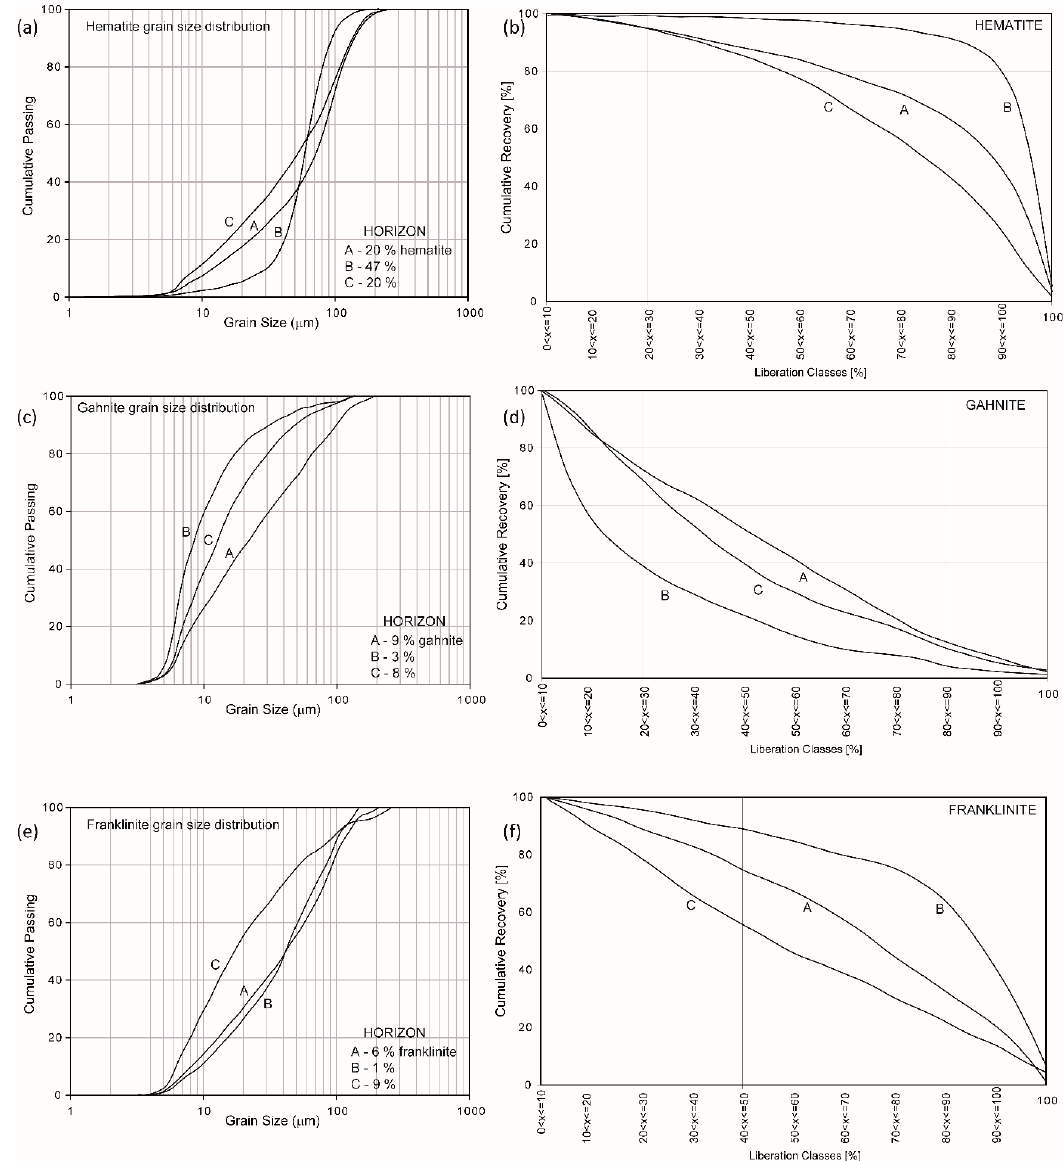
Figure 6. Grain size distribution and proportion of associated minerals for a range of liberation classes for ( a , b ) hematite, ( c , d ) gahnite and ( e , f ) franklinite. Liberation classes show how much of the particle area is composed of associated phases, i.e., 100% means that the phase is fully liberated and not associated with any other phase.